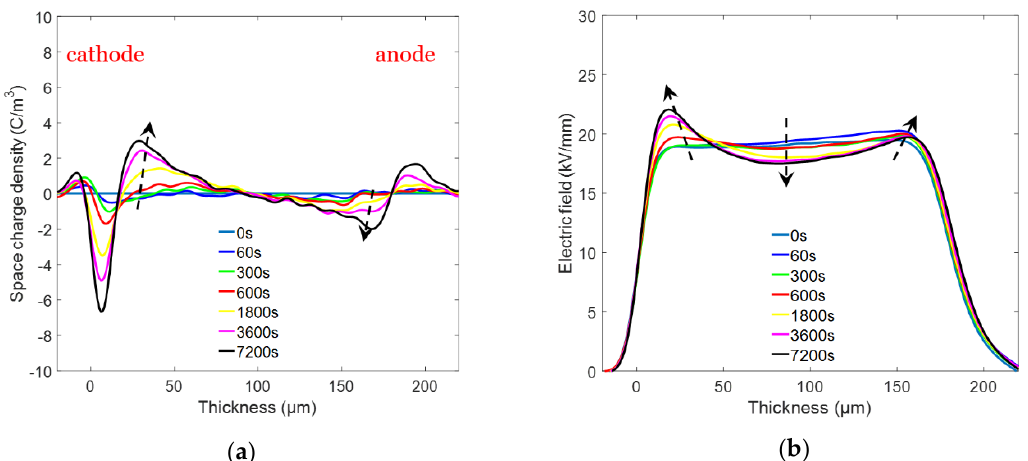
Figure 4. ( a ) Space charge behaviour in fresh XLPE samples at 20 kV/mm field (capacitive charge removed). ( b ) Electric field distribution across the fresh XLPE film.